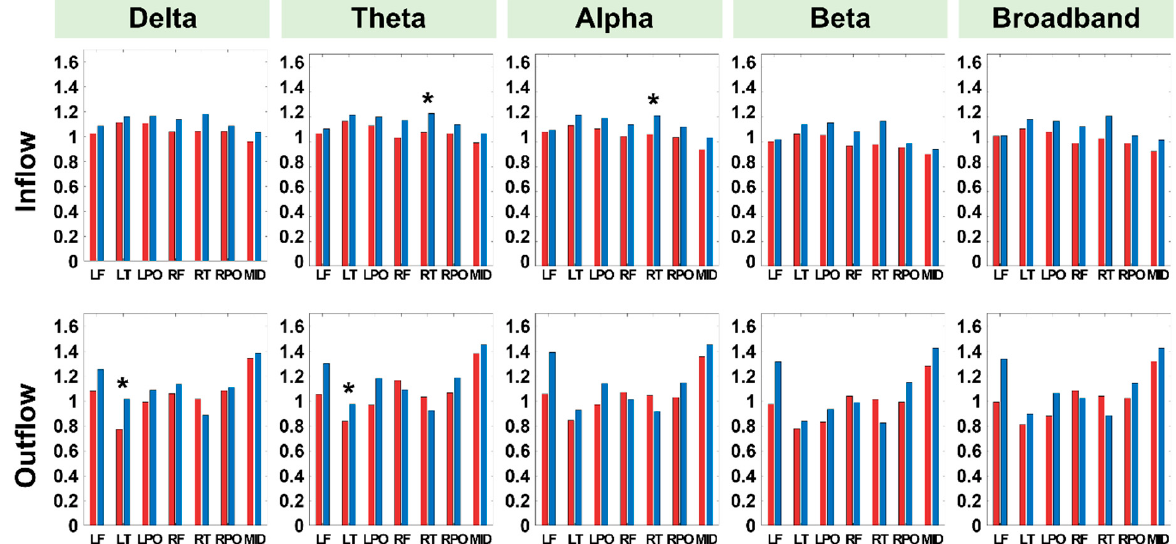
Figure 3. Comparison of the inflow and outflow connectivity measures between the responder and nonresponder groups in the presurgical state. The asterisk denotes a statistically significant difference between the two groups.